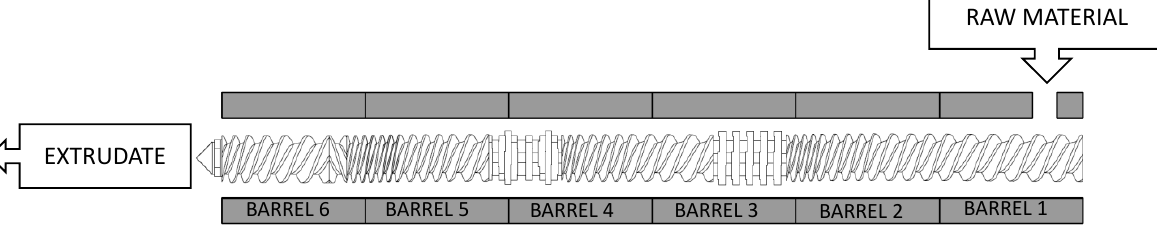
Figure 1. Screw configuration for the extrusion of vegetal tomato plant waste (VTPW) in a twin-screw extruder.